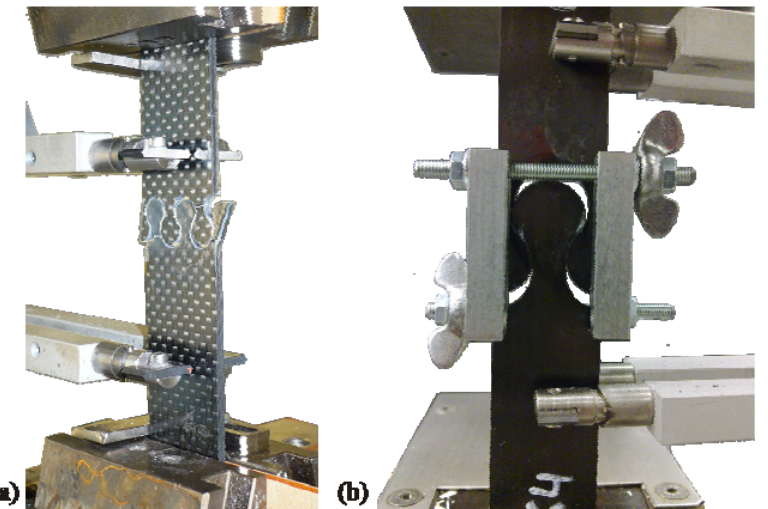
Figure 7. ( a ) Lateral bending of interlock elements; ( b ) Avoided lateral bending by using guiding